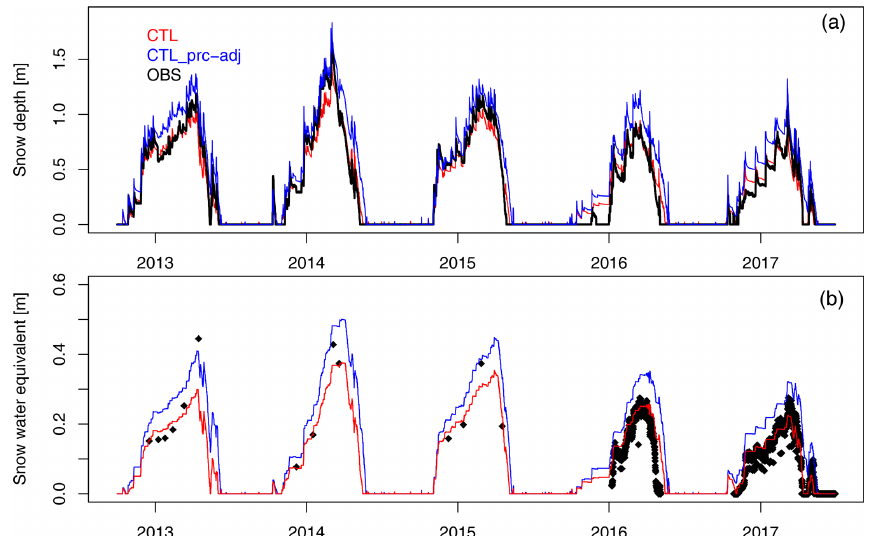
Figure A2. Snow depth (a) and snow water equivalent (b) simulated by the SNOWPACK model when the adjusted total precipitation forcing is employed (CTL_prc-adj) compared to the control run (CTL) and